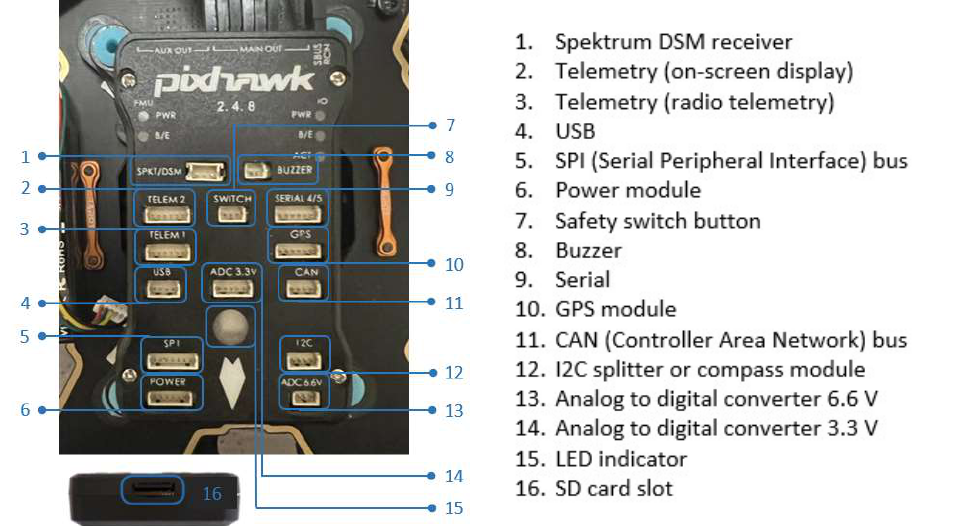
Figure 9. Pixhawk 2.4.8 flight controller and the peripheral connection interfaces.